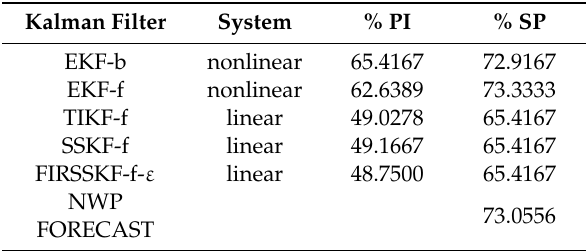
Table 2. E ff ectiveness of KF prediction algorithms used in output power